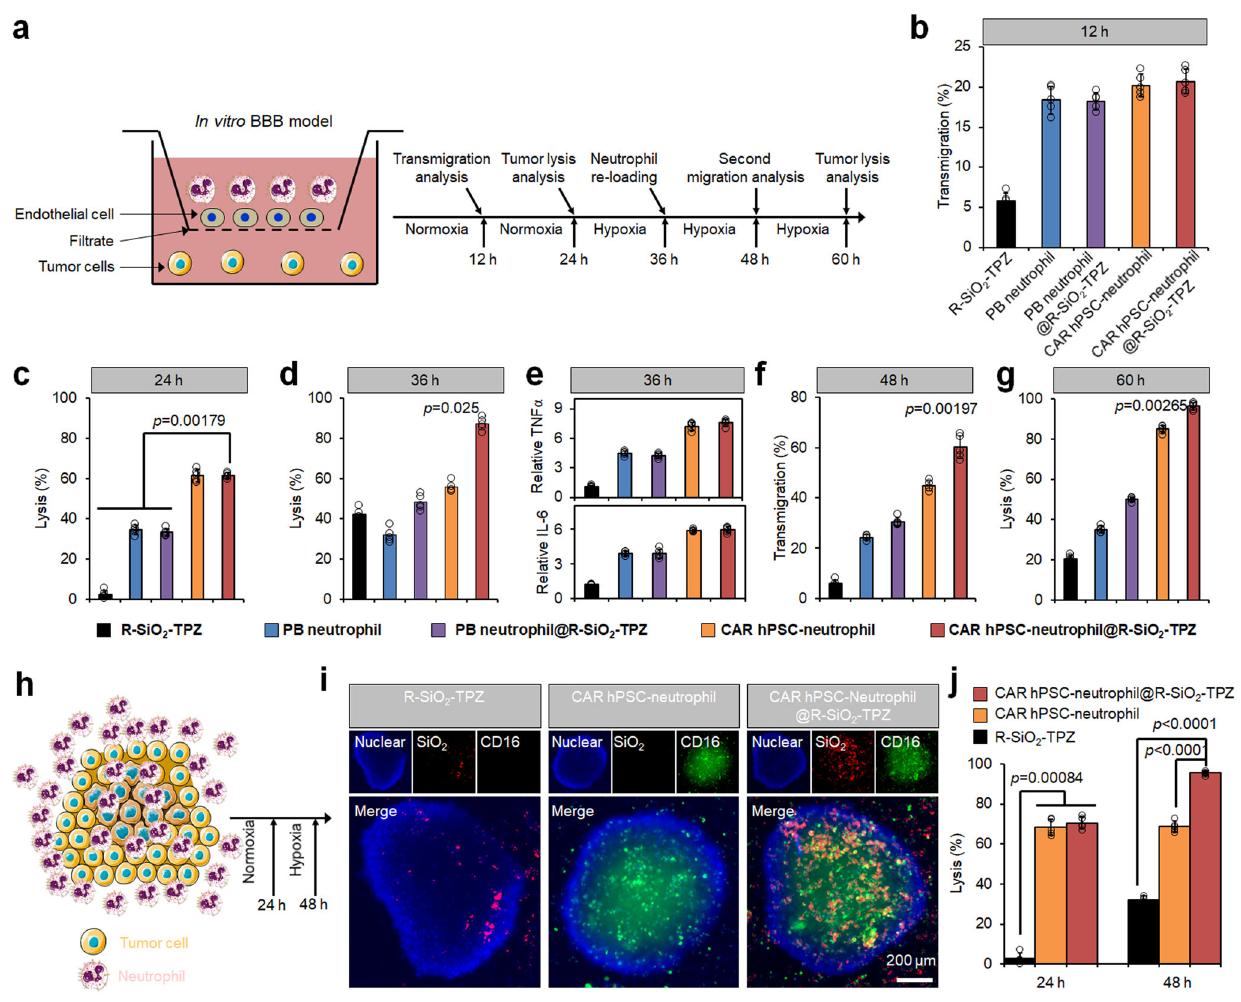
Fig. 5 | Functional evaluation of CAR-neutrophils loaded with R-SiO 2 -TPZ nanoparticles using biomimetic glioblastoma (GBM) models in vitro. a Schematic of our in vitro tumor model of GBM with blood-brain-barrier (BBB), whichiscomposedofendothelialcellsonthecellinsertmembraneandtumorcells in the bottom of the same transwell. b Transwell migration analysis of neutrophils at12hisshown.Anti-GBMcytotoxicityofindicatedneutrophilsat24h( c )and36h ( d ) was measured and quanti fi ed. e ELISA analysis of IL-6 and TNF α released from indicated neutrophils at 36h was performed. f Second migration of different neutrophils at 48h is shown. g Anti-GBM cytotoxicity of indicated neutrophils